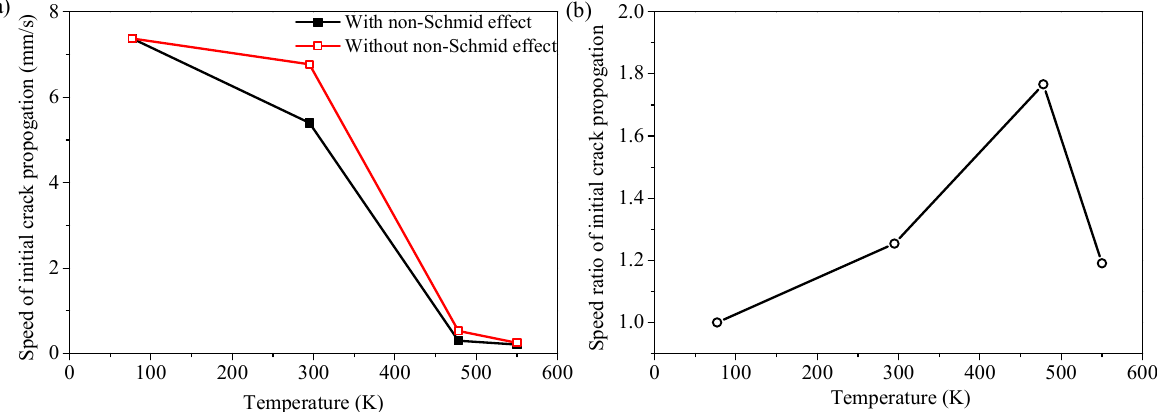
Figure 8. Influence of NS effect on the speed of crack propagation at different temperatures. ( a ) Speed of initial crack propagation from 77 K to 550 K. ( b ) Speed ratio of the initial crack propagation, which is the ratio of the initial crack propagation speed without the NS effect to the one with this effect and was calculated from ( a ).